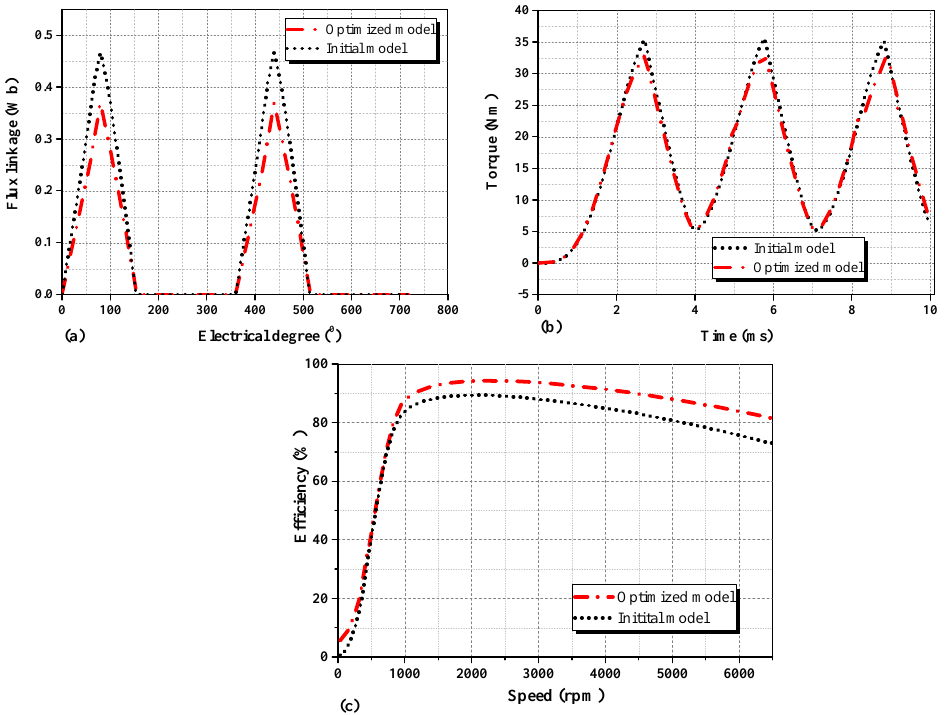
Figure 16. Comparison of motor performance of the initial and optimized model ( a ) Flux linkage characteristics ( b ) Torque profile ( c ) Motor efficiency with